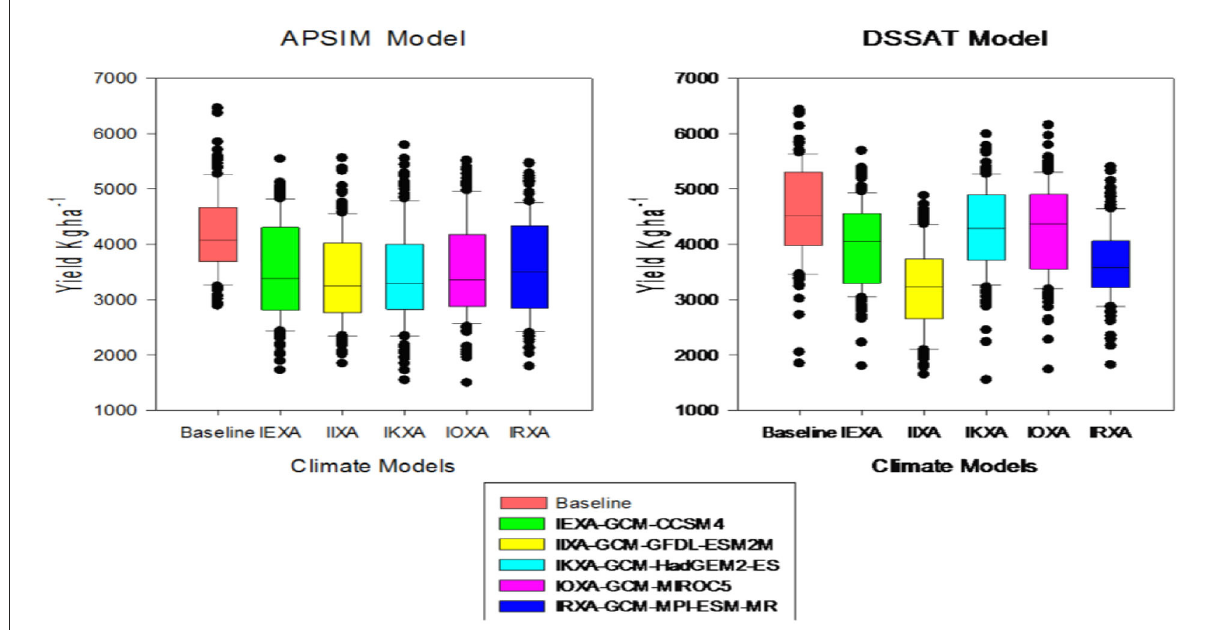
FIGURE7 Reduction in rice yield of APSIM and DSSAT models for 155 farms; variation with 5-GCMs in rice-wheat cropping system of Punjab-Pakistan.